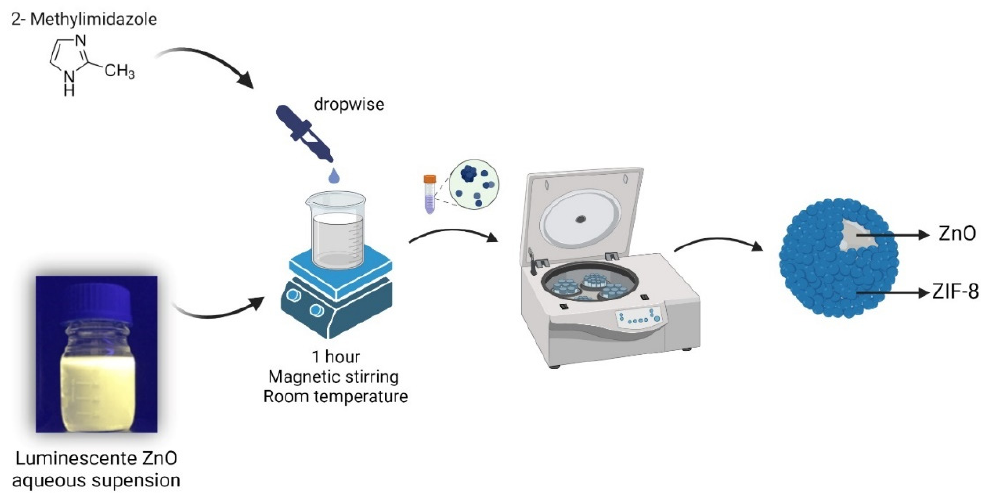
Figure 1. Schematic of ZnO@ZIF-8 NPs formation. To confirm the formation of the ZnO@ZIF-8 conjugate structure, XRD and IR tests were performed. The XRD patterns (Figure 2A) of the materials showed the typical Bragg peaks of the ZIF-8 and ZnO topology, confirming that the desired crystal structures of both materials were obtained. The peaks were indicated by the filled circles in positions 7.31°, 10.32°, 12.86°, 14.66°, 16.60°, 18.03°, 22.17°, 24.45°, and 26.80° 2 θ , corresponding to symmetry planes (011), (002), (112), (022), (013), (222), (114), (233), and (131), respectively. (empty circles), referring to the crystalline structure of ZnO, remained with the formation of ZnO@ZIF-8, which can be represented by the peaks at positions 36.66°, 56.36°, 63.12°, and 68.44° 2 θ , referring to the planes of symmetry (102), (110), (103), and (112), respectively, of the wurtzite hexagonal structure (JPCDS card number: 36-1451) [23]. Figure 2B shows the FTIR spectra of the ZIF-8 and ZnO@ZIF-8 NPs. It can be observed that all samples present very high similarities. According to Feng et al., at higher frequencies, ZIF-8 showed two small stretch bands present at 3132 and 2926 cm − 1 , which can be attributed to the C-C vibrational stretching of the imidazole ring and the methyl group present in the ligand, respectively. The band at 1585 cm − 1 can be attributed to C=N, while the bands at 1430 and 1313 cm − 1 correspond to the elongation of the entire ring. Some bands, between 1350 and 900 cm − 1 , can be attributed to the angular flexion of the ring, and bands 763 and 692 cm − 1 can be related to the aromatic C-H elongation. The band present at 421 cm − 1 corresponds to the Zn-N stretch with zinc in the ZIF-8 structure, which binds to 2-MeIM nitrogen atoms during the formation of ZIF-8. On the other hand, the band at 482 cm − 1 corresponds to the formation of the Zn-O bond [24], indicating the presence of ZnO in the material. However, due to the encapsulation of the ZnO within the structure of ZIF-8, the rest of the characteristic bands of ZnO were probably masked, which suggests that ZIF-8 is providing additional protection for the nanoparticle.